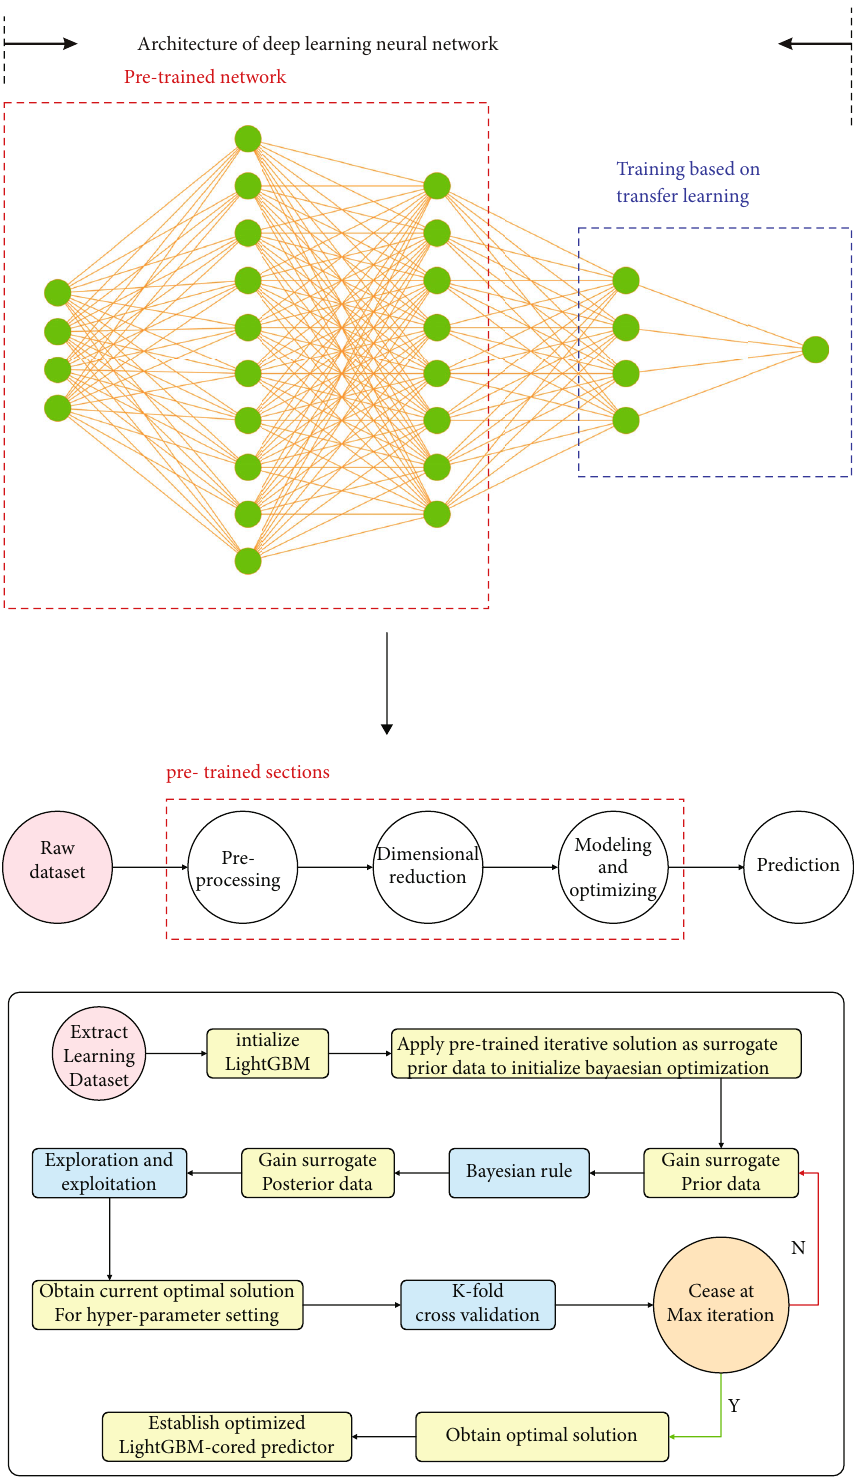
Figure 2: Computing fl ow of LightGBM-cored predictor for petrophysical regression of sandy-mud reservoirs based on transfer learning. LightGBM=light gradient boosting